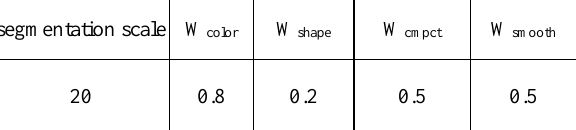
Table 2. Multi-scale segmentation parameters of GF-3 SAR